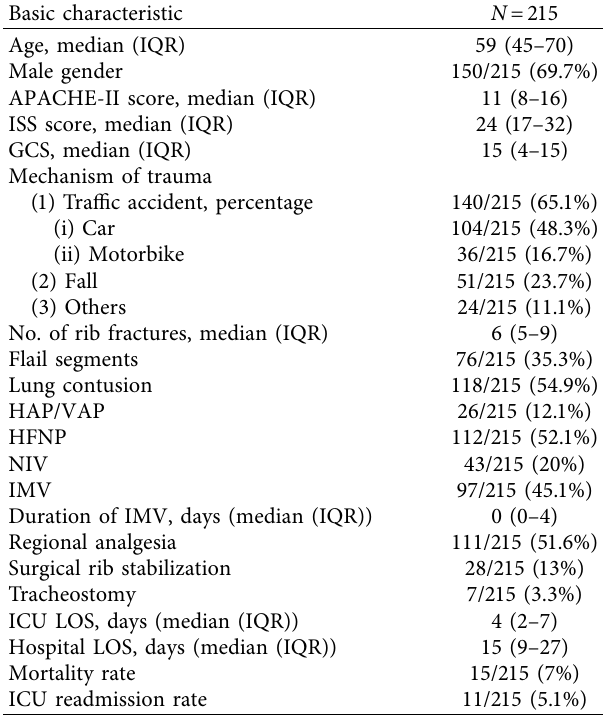
Table 1: Demographic characteristics and interventions of the